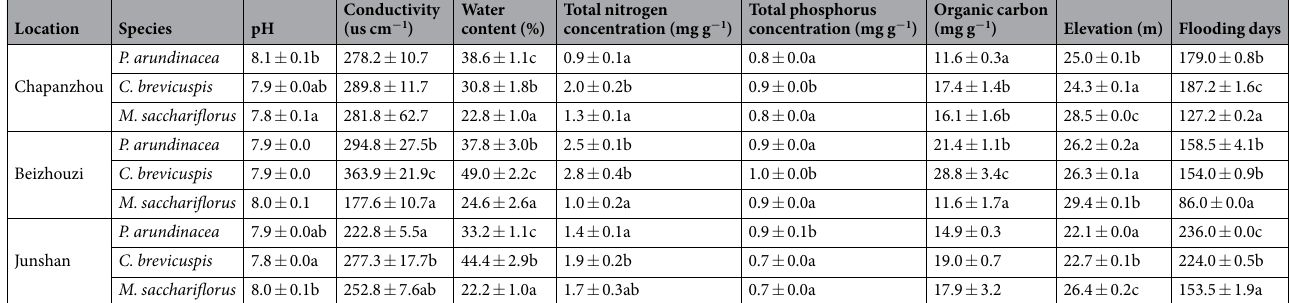
Table 2. Physico-chemical characteristics (means ± SE) of soil in the 3 wetland plant communities distributed along an elevation gradient of 3 lakeshores areas in Dongting Lake, China. Different letters indicate significant differences among treatments at the 0.05 significance level.